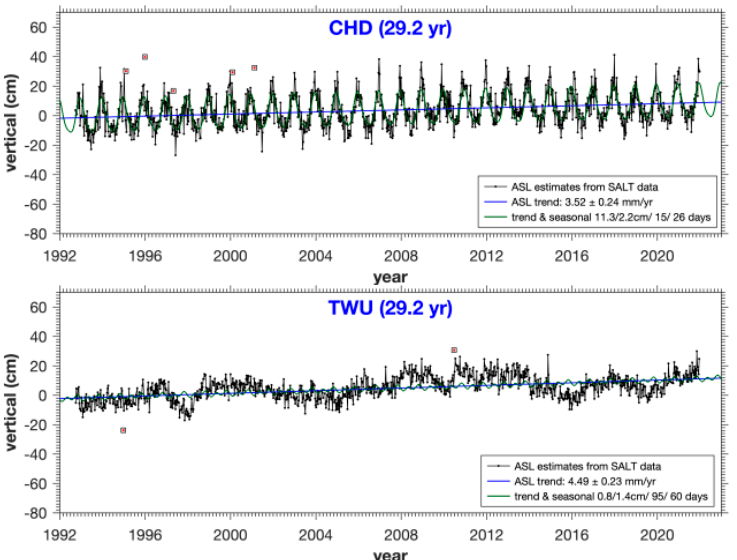
Figure 5. Absolute sea-level trend and annual and semi-annual cycle estimates from the satellite altimetry time series (1992–2021) for CHD (Kuala Terengganu) in Peninsular Malaysia and TWU (Tawau) in Sabah, East Malaysia. For each tide-gauge location, the vertical position time series is given along with the total observation period. The reference vertical position is at the start of the satellite altimetry time series in 1992. The linear trend lines are given in blue with the modeled seasonal (annual and semi-annual) signal (green) superimposed on it. Outliers are marked in red. The absolute sea-level trend estimate is given at a 95% (1.96 sigma) confidence level. Table 4. ASL trend results (1992–2020) from SALT for the TG locations in Peninsular Malaysia. The average distance of the altimeter along-track data to the TG station location is given in the 2nd column. For the periodic cycles (annual and semi-annual), the amplitude and phase are given where the latter is transformed to days after 1 January. The residual sigma is the SD of the differ- ence between data and model fit. The ASL trend estimates are given at a 95% (1.96 sigma) confi- dence level. TG Station SALT Station (km) ASL Trend (mm/year)